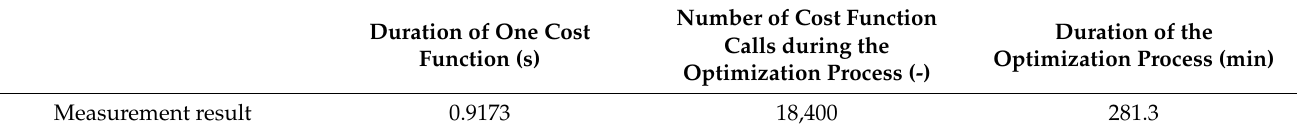
Table 5. Measurement data of the optimization process related to time